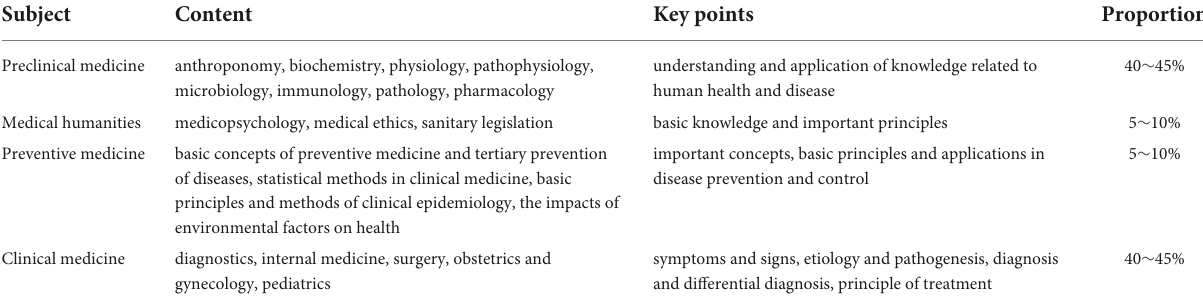
TABLE 1 Summary of content and scope of Standardized Competence Test for Clinical Medicine Undergraduates